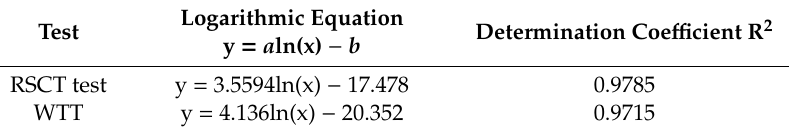
Table 6. The fitting formula of the